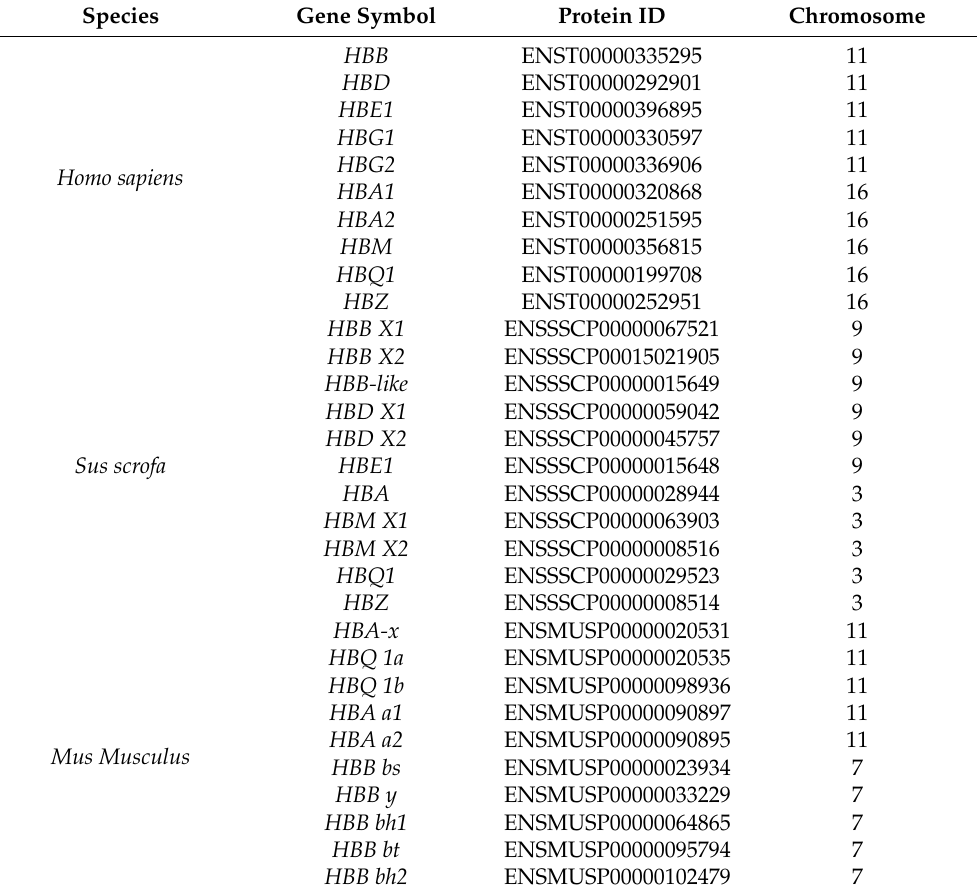
Table 2. Human, pig and mouse hemoglobin-encoding